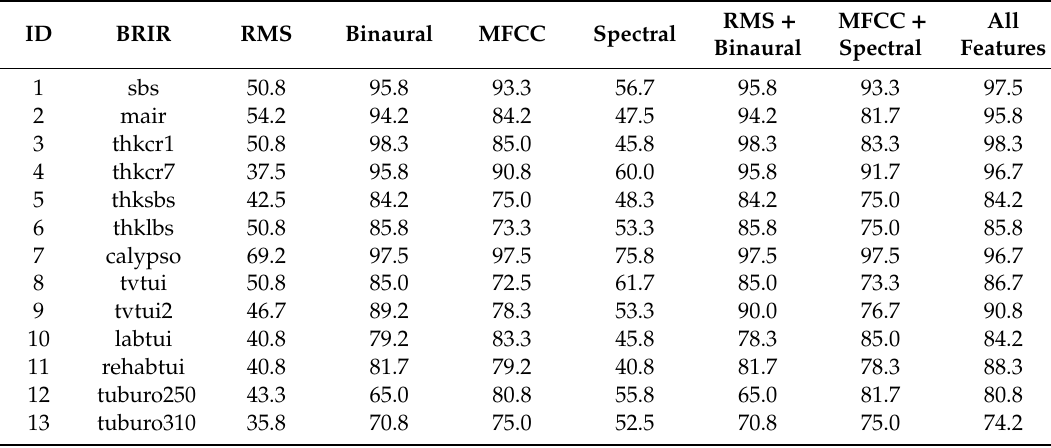
Table 6. Testing accuracy (%) of the models obtained using subsets of recordings synthesized with individual BRIR sets. Each testing subset consisted of 120 audio